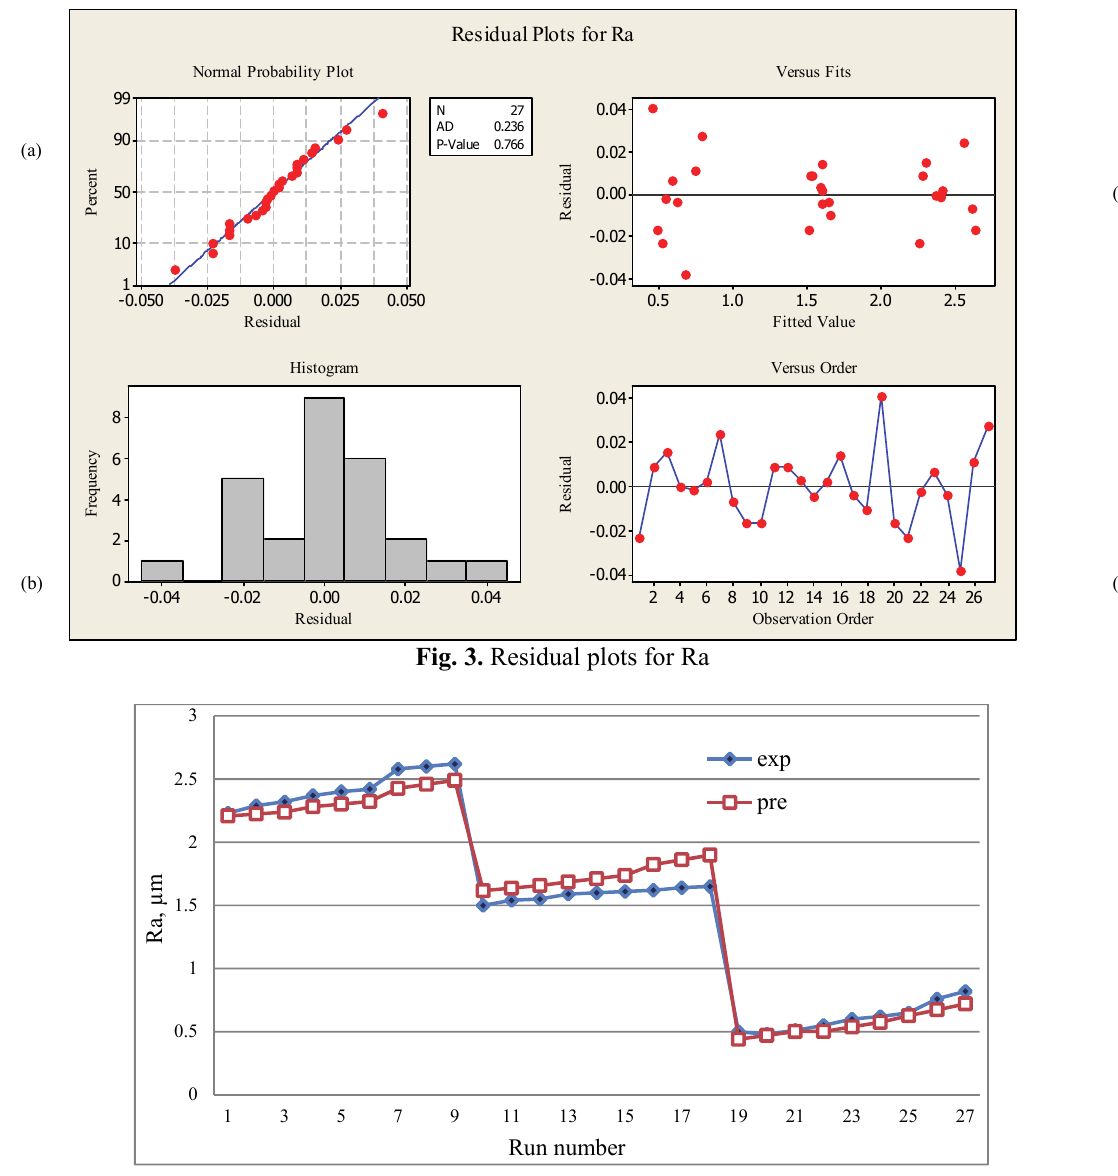
Fig. 4. Comparison between the predicted (pre) and measured (exp) values for R a